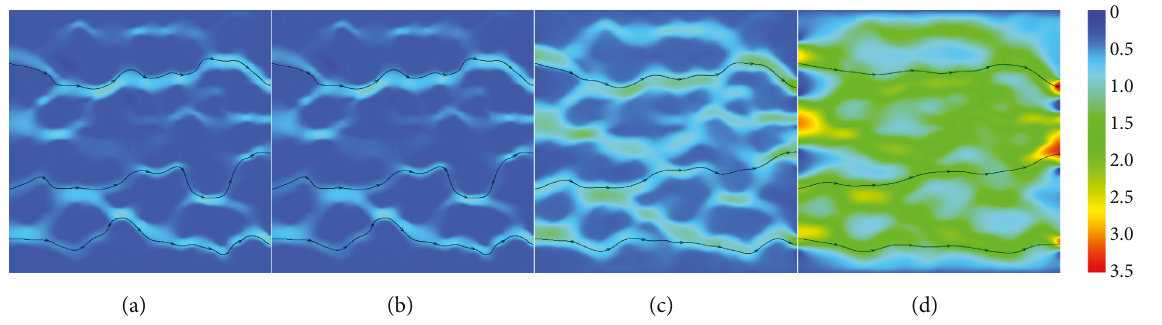
Figure 8: Velocity magnitude distribution in the porous media under di ff erent matrix porosities. (a) porosity = 0 05 , (b) porosity = 0 1 , (c) porosity = 0 2 , and (d) porosity = 0 4